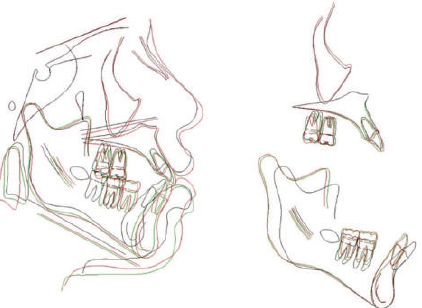
Figure 20: Overall superimposition, Stage 1 final (black line), presurgical (green line), and Stage 2 final (red